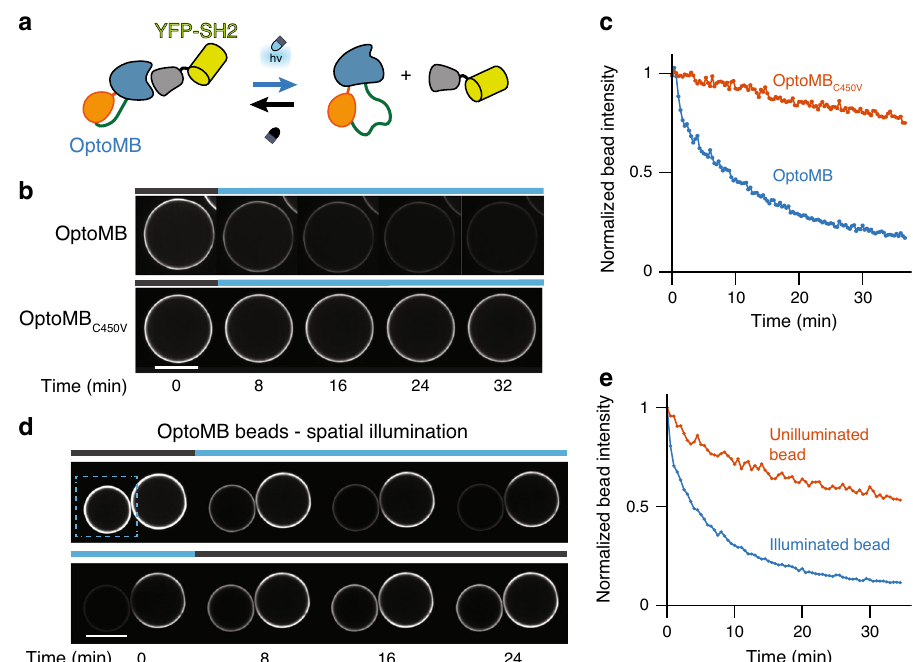
Fig. 2 In vitro characterization of OptoMB using agarose beads. a Schematic diagram of OptoMB and YFP-SH2 darkness-dependent interaction. In the dark, OptoMB binds to the SH2 domain of YFP-SH2 fusion; upon blue light stimulation, the AsLOV2 domain disrupts the HA4 domain of OptoMB, reducing its af fi nity for SH2. b Time course of fl uorescence microscopy images of YFP-SH2 binding to agarose beads conjugated with OptoMB (top panel) or OptoMB C450V as control (lower panel). Starting with beads incubated in the dark, time course begins upon blue light stimulation ( t = 0), followed by a sequence of images taken every 8 min for a total of 32 min (see Supplementary Movie 2). The bar on top of each time course indicates when the illumination (450 nm) is on (blue) or off (gray) c Quanti fi cation of the time course fl uorescence microscopy experiments shown in b for the beads coated with OptoMB (blue) and the ones coated with the light-insensitive control OptoMB C450V (orange). d Light-enabled spatial control of OptoMB binding demonstrated in two OptoMB-coated agarose beads incubated in a circulating solution of YFP-SH2. The blue rectangle in the left panel indicates the area used to illuminate only one bead. The top panel shows YFP-SH2 unbinding in illuminated area as beads go from darkness to 24 min of illumination. The bottom panel shows illuminated bead recovery (reversibility) after turning off the blue light for another 24min (see Supplementary Movie 3). e Quanti fi cation of spatially controlled binding experiments of YFP-SH2 to two OptoMB-coated agarose beads, shown in d , showing normalized YFP fl uorescence intensity of both illumined (blue) and unilluminated (orange) beads over time. Scale bars (white) represent 100 μ